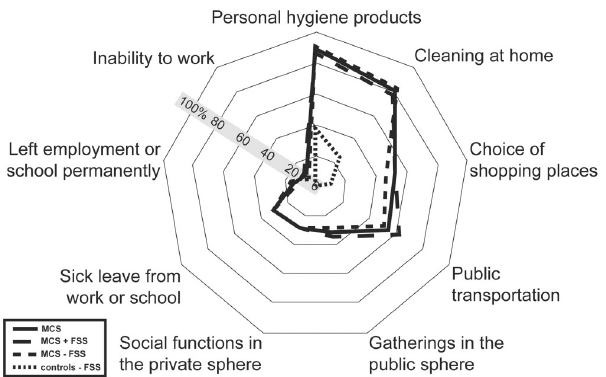
Fig 3. Prevalence of participants reporting adjustments of behaviour due to symptoms related to inhalation of airborne chemicals. Abbreviations: MCS = Multiple chemical sensitivity; FSS = functional somatic syndromes; MCS all = all participants meeting criteria for multiple chemical sensitivity; MCS + FSS; participants meeting criteria for multiple chemical sensitivity and one or more comorbid FSS. MCS � FSS = participants meeting criteria for multiple chemical sensitivity but not comorbid